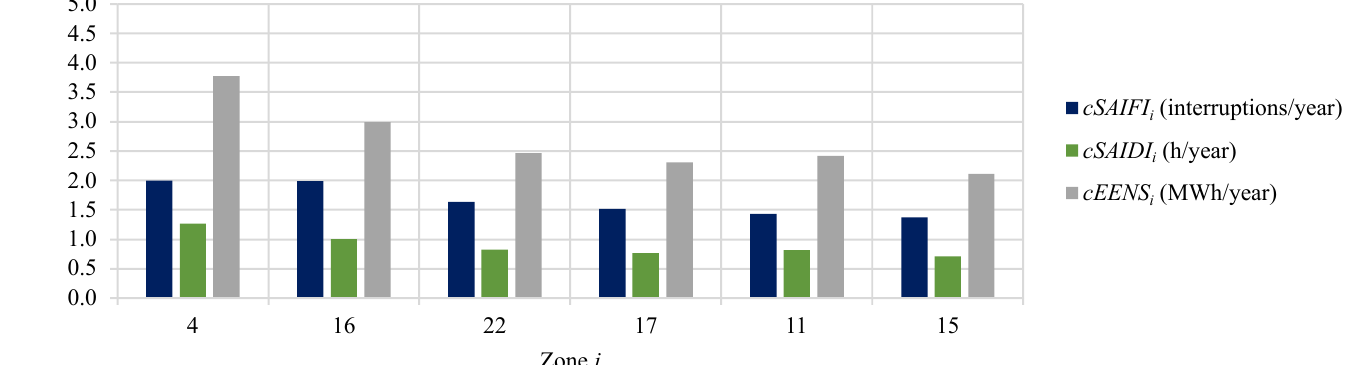
Figure 9. Zones with highest contribution of faults to the reliability indices obtained using the proposed method.